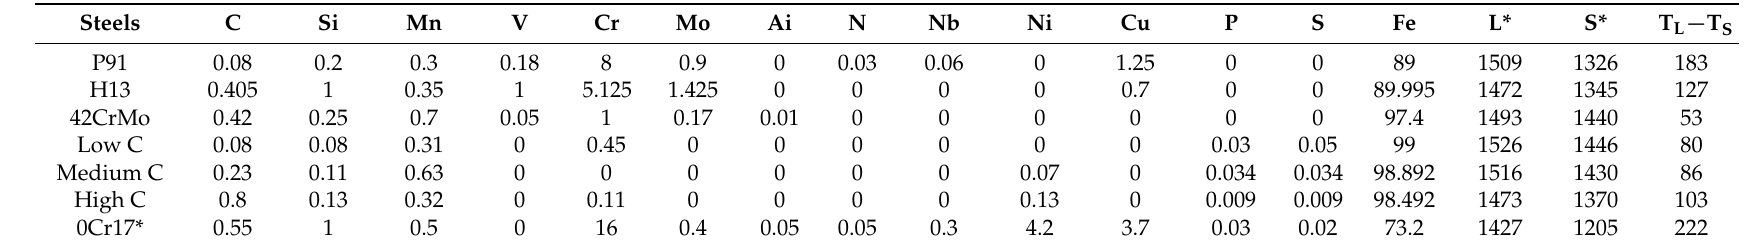
Table 2. Correlation of mushy zone to chemical composition of